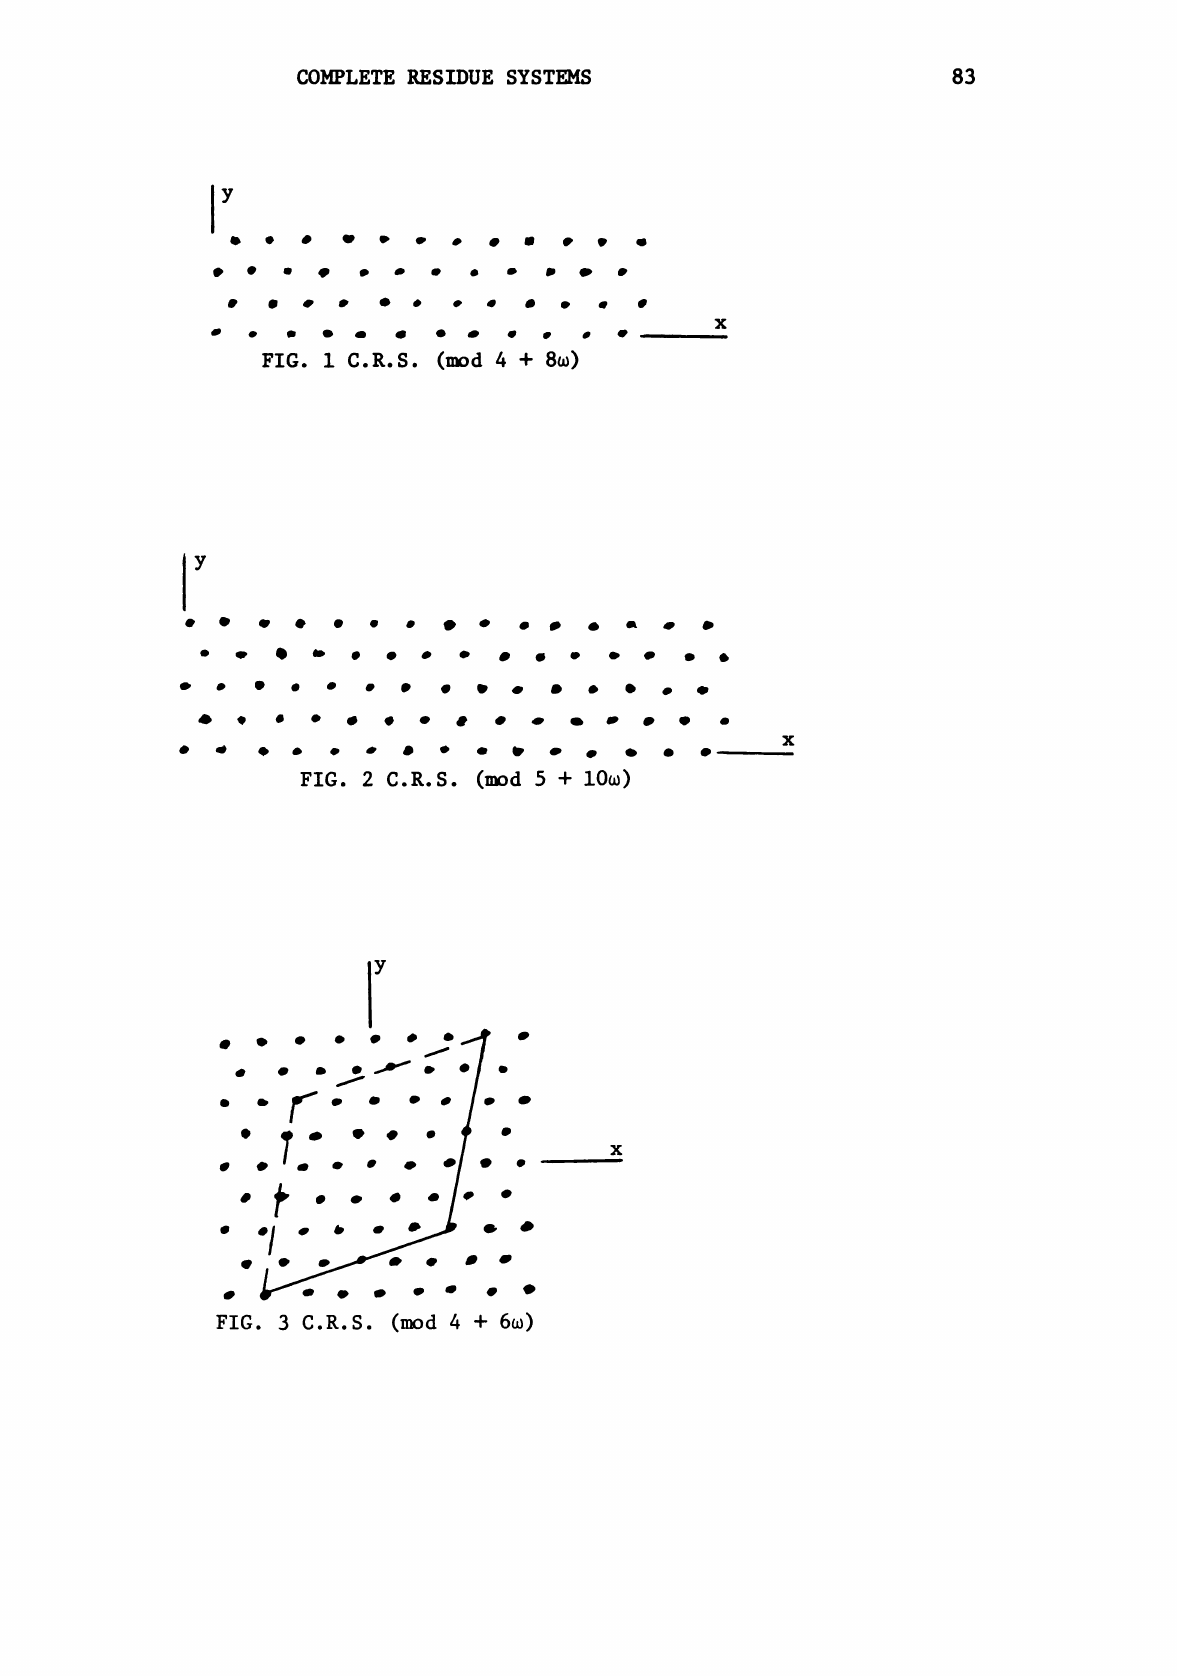
FIG. 1 C.E.S. (d 4 + 8)